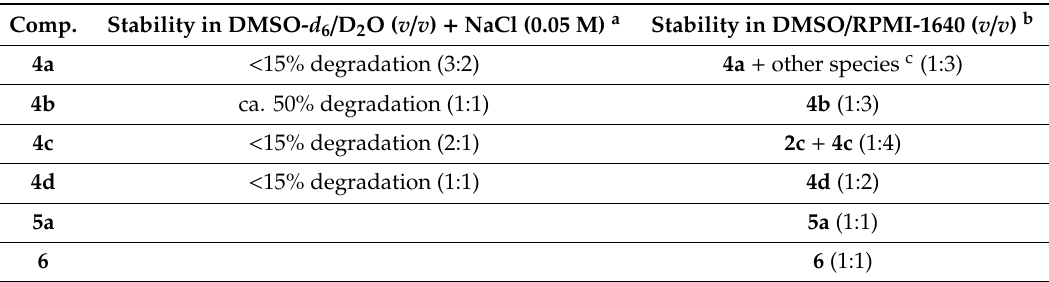
Table 6. Overview of stability of compounds in aqueous